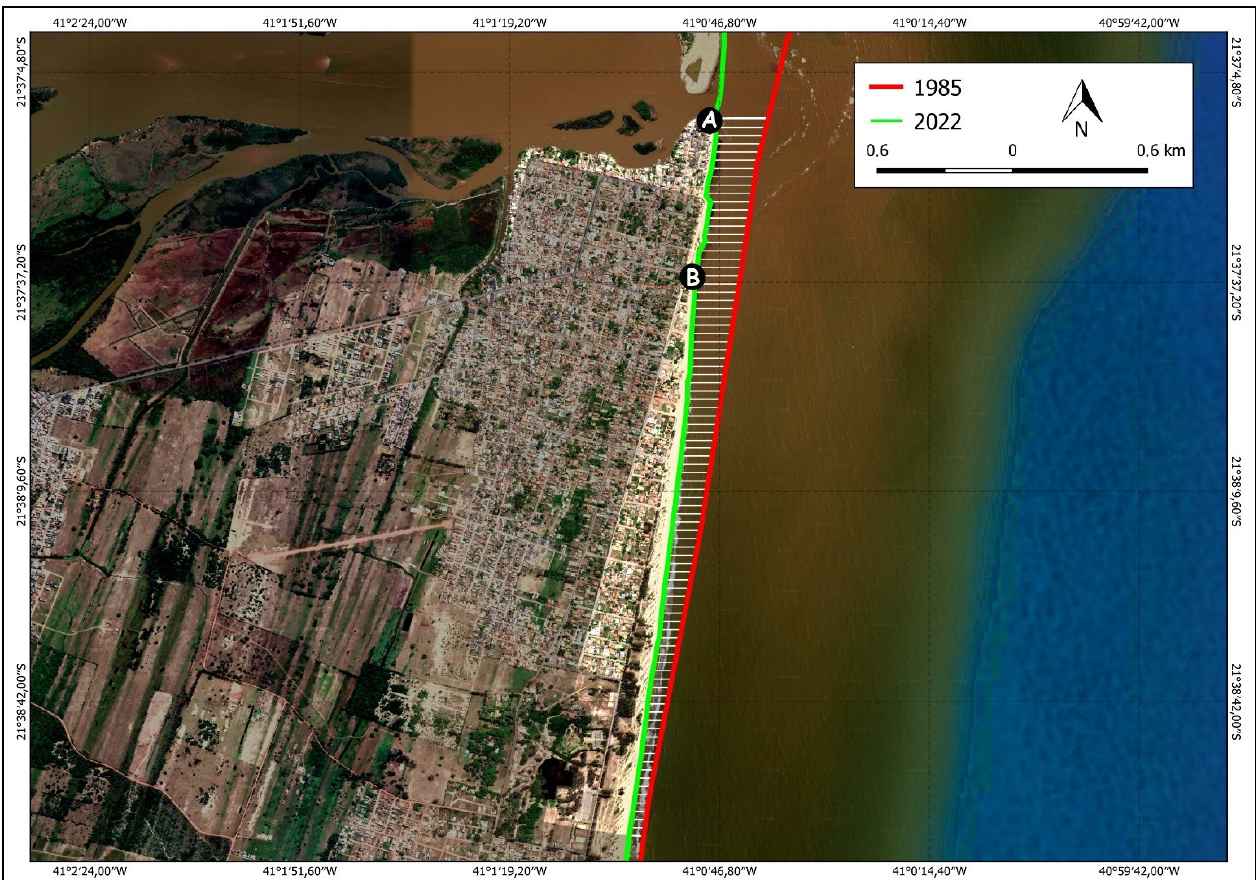
Figure 8. Image of 1985 coastline overlapped with the current one, showing the areal gap due to erosion. The image brightness enhancement applied in the intense coastal erosion zone was performed following a vertical urban road in the S-N direction, allowing the visualization of the loss of urban blocks caused by the horizontal displacement of the coast. See Figure 9 for the photos related to A and B (black circles).